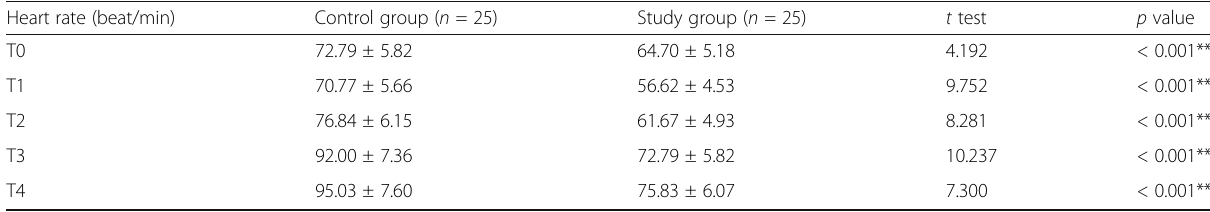
t independent sample t test, ** p value < 0.001